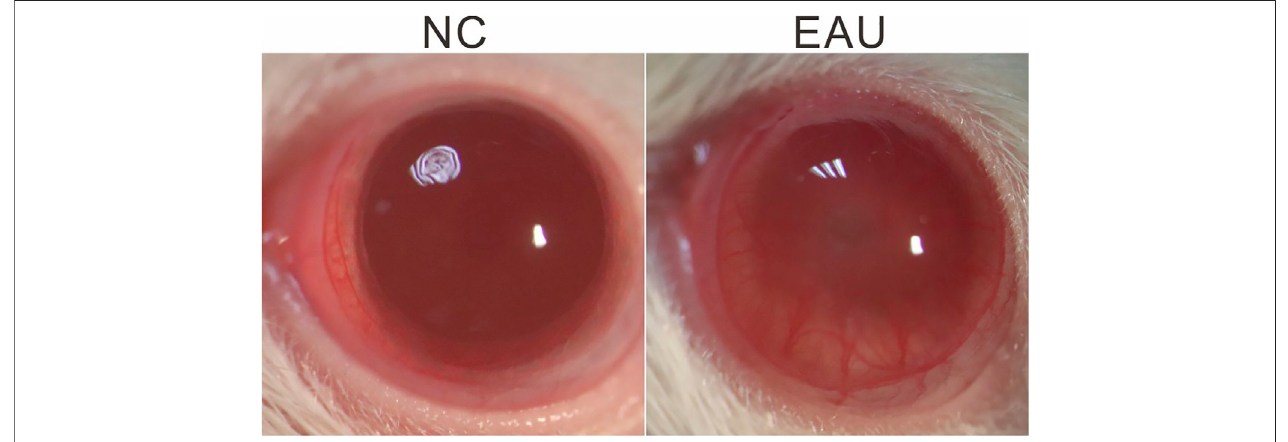
FIGURE2| Theexpressionpro fi lesofmRNAsandlncRNAs.TheamountofthecommonandtheuniquelyexpressedmRNAs (A) andlncRNAs (C) arepresentedin Venn diagram. The volcano plot of differentially expressed mRNAs (B) and lncRNAs (D) .